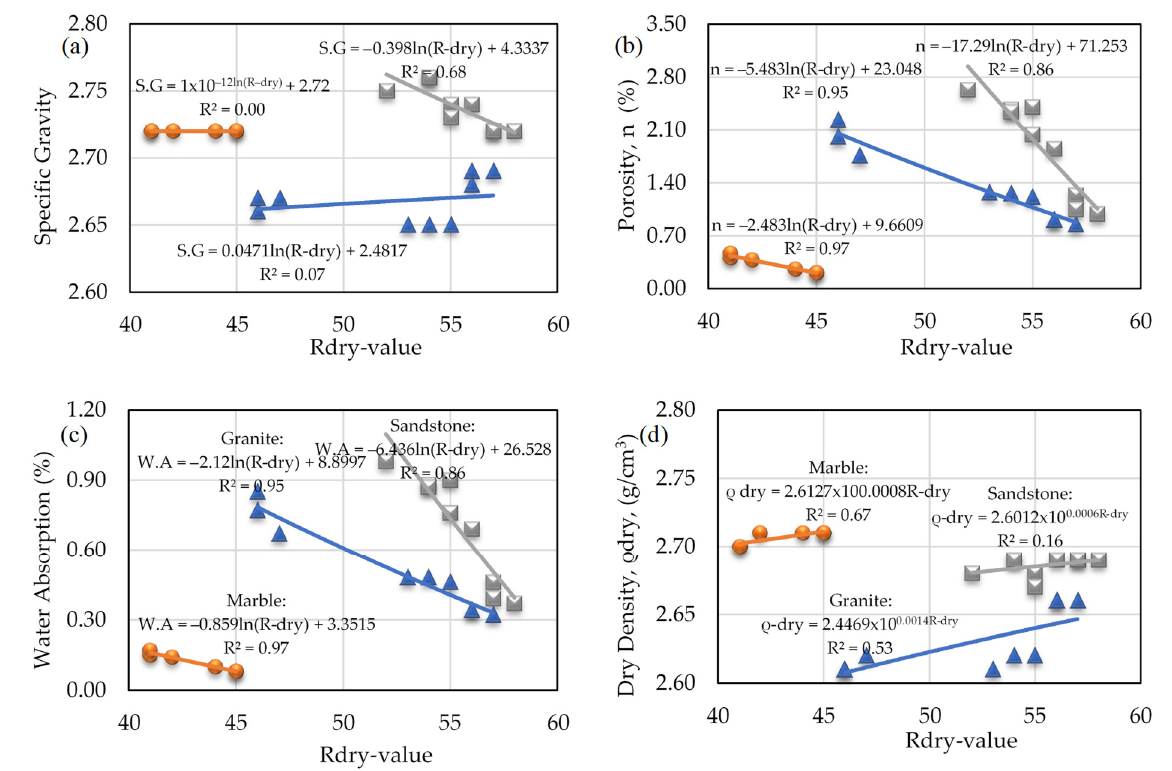
Figure 7. Correlation of R dry -value against ( a ) Specific gravity, ( b ) Porosity, ( c ) Water absorption and ( d ) dry density for granite, marble and sandstone. Table 5. Statistical relations of NDTs-dry with physical properties.